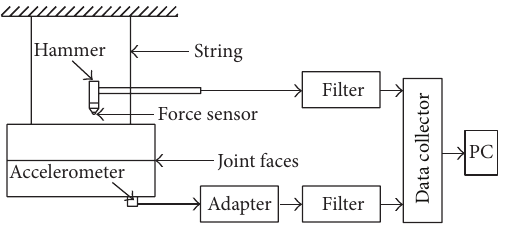
Figure 8: Experiment set-up.